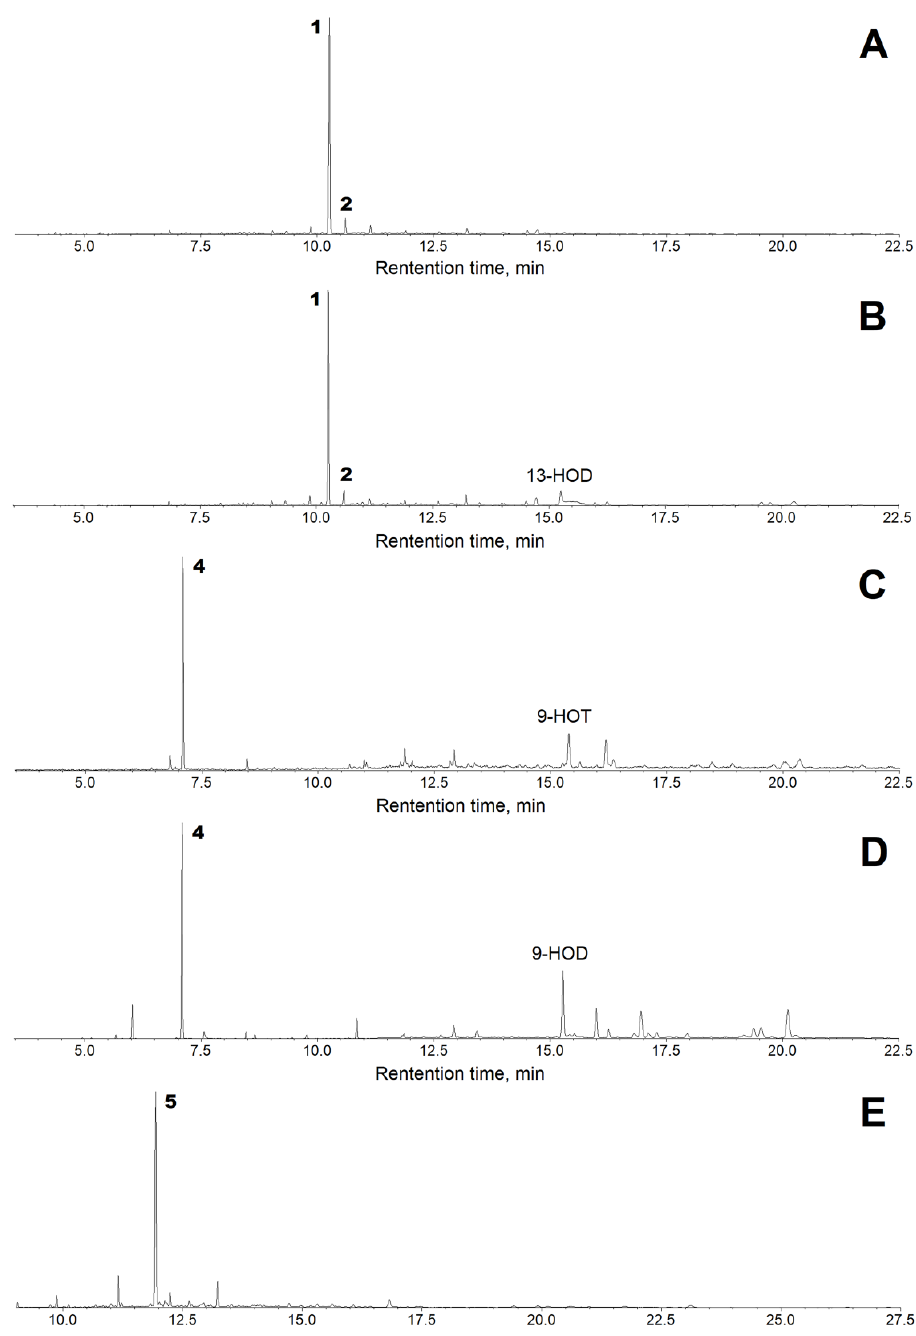
Figure 6. The total ion current GC–MS chromatograms of the products (Me/TMS) of incubation of 13-HPOT ( A ), 13-HPOD ( B ), 9-HPOT ( C ), 9-HPOD ( D ), and 15-HPEPE ( E ) with recombinant CYP74C44 of S. hondurensis. Conditions of incubation, extraction, derivatization, and analysis are described in Section 4. Abbreviations: 13-HOD, (9Z,11E,13S)-13-hydroxy-9,11-octadecadienoic acid; 9-HOT, (9S,10E,12Z,15Z)-9-hydroxy-10,12,15-octadecatrienoic acid; 9-HOD, (9S,10E,12Z)-9-hydroxy- 10,12-octadecadienoic